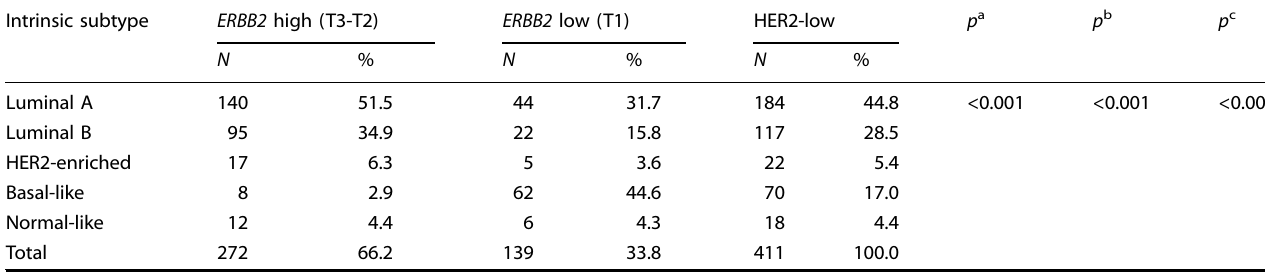
Table 3. Intrinsic subtypes distribution in HER2-low tumors according to ERBB2 mRNA levels. Intrinsic